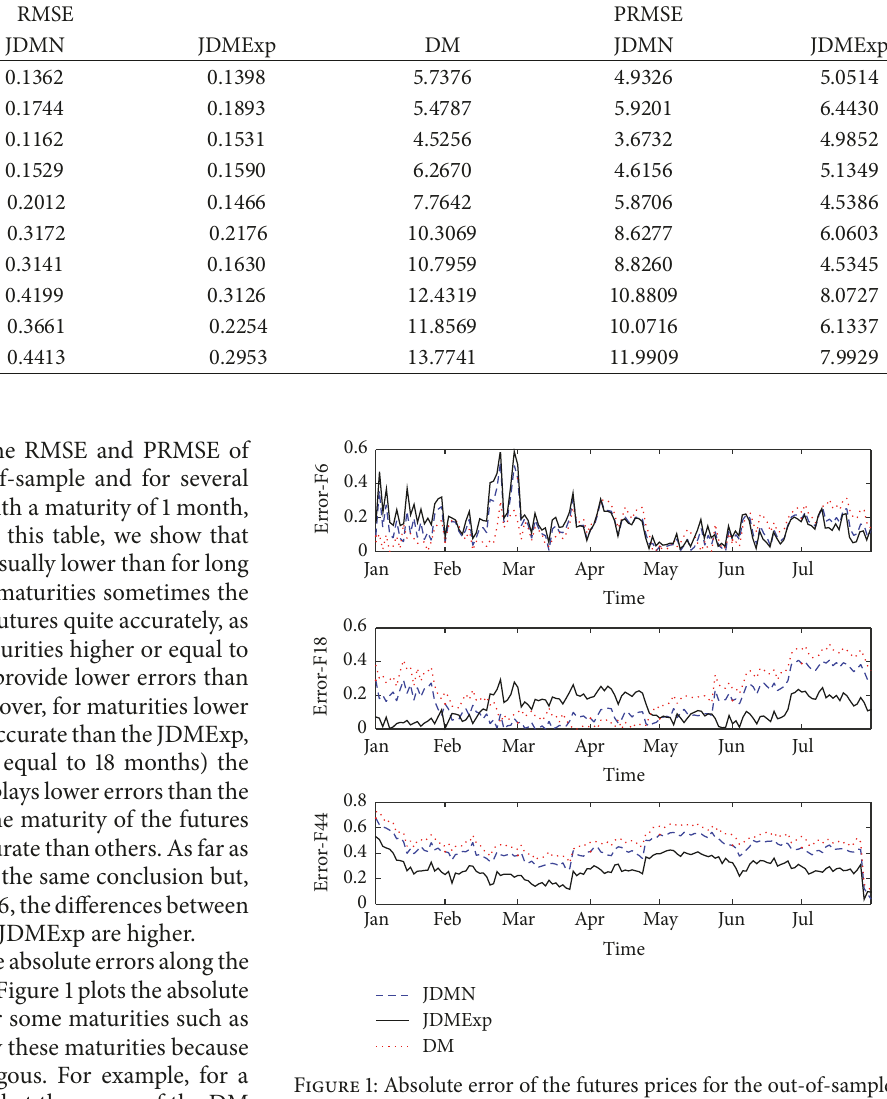
Table 1: RMSE and PRMSE for the out-of-sample (January–July 2015) for DM, JDMN, and JDMExp models.